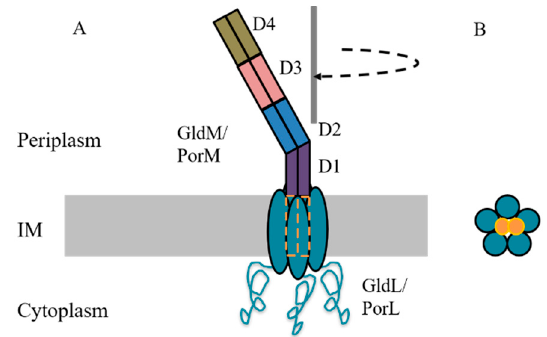
Figure 2. Cartoon representation of the GldL/M motor complex. ( A ) GldL/PorL forms a pentameric ring in the inner membrane. A dimer of GldM/PorM is inserted inside the GldL/PorL ring and domains D1 to D4 span the periplasm. The bend between D1 and D2 allows it to rotate in a wide circle. ( B ) Cross-section view showing pentameric arrangement of GldL/PorL and packed GldM/PorM helices in the middle. Figure adapted from [41]. IM: inner membrane